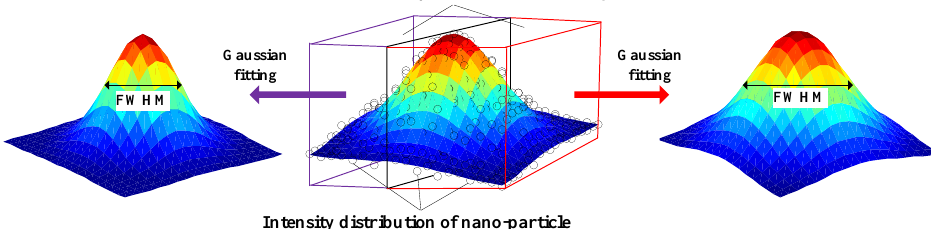
Figure 5. Fitting the two divisions of the nanoparticle’s intensity distribution with a Gaussian function.